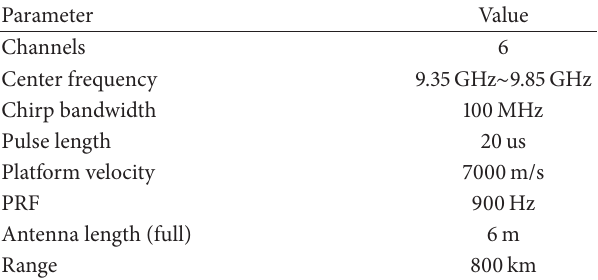
Table 1: Simulation